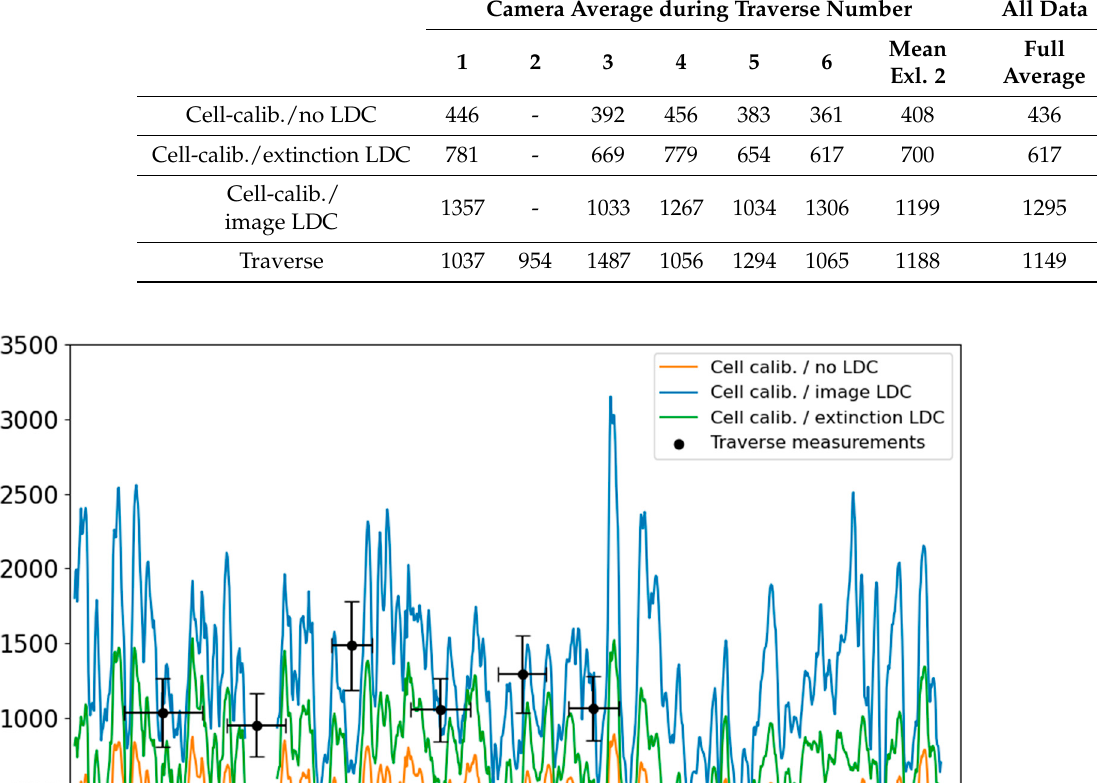
Table 1. Average SO 2 emission rates (in metric tons/day) as measured by camera methodologies, with different light dilution corrections (LDC) and traverses for 13 January 2018 for each traverse time interval. An overall average for all measurements from the day is also included.